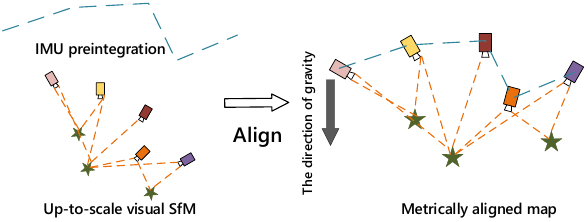
Figure 3. Illustration of the visual-inertial alignment process for